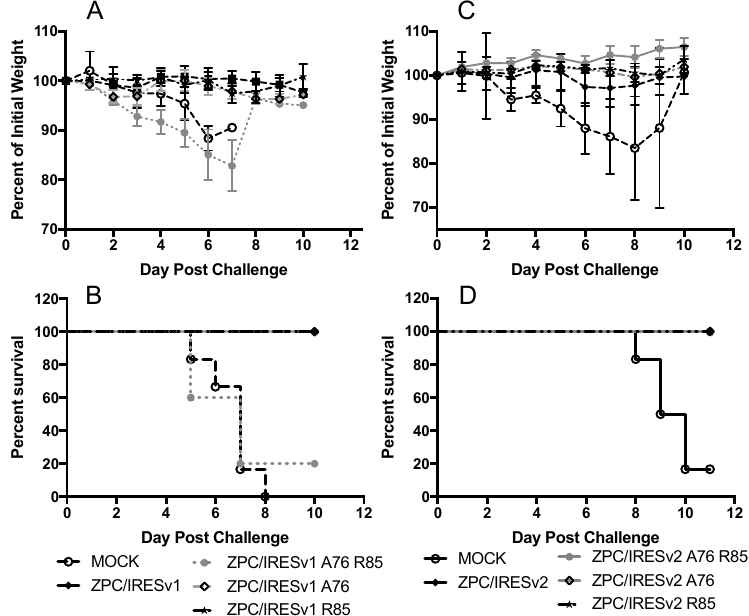
Figure 7. Mutant vaccine efficacy in adult CD1 mice. ( A , B ) show the percent of initial weight and survival from ZPC/IRESv1-derived vaccines, respectively. The same key is used for panels ( A , B ). ( C , D ) show the percent of initial weight and survival from ZPC/IRESv2-derived vaccines, respectively. Error bars denote standard error. The same key is used for panels ( C , D ).